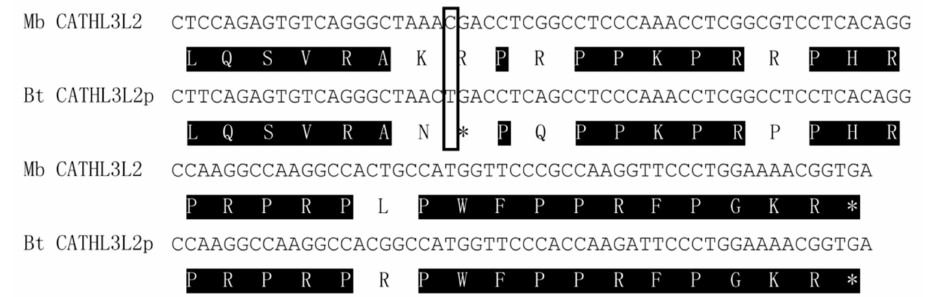
Figure 3. Sequence comparison of C-terminal sequences of CATHL3L2 from the forest musk deer (Mb) cattle (Bt). Identical amino acids are shadowed, and the asterisk represents the termination codon. The nucleotide position that caused the pseudogenization of the cattle CATHL3L2 was boxed.